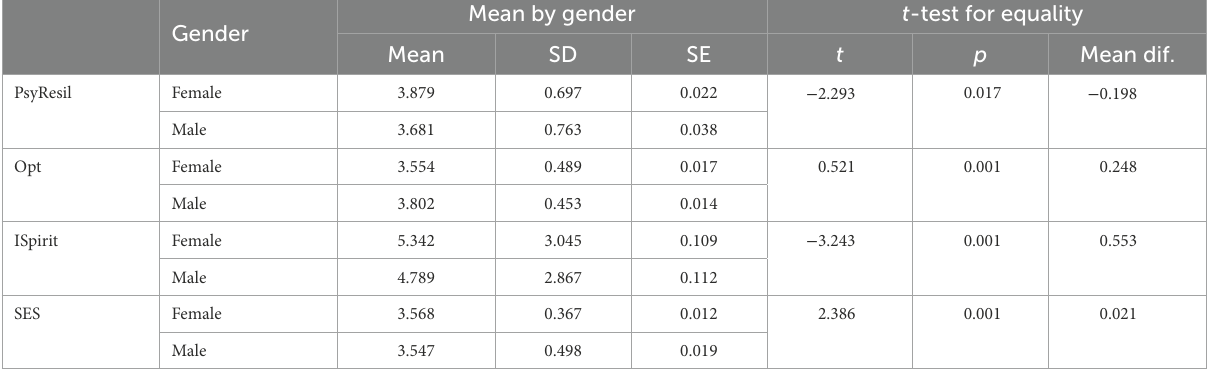
TABLE 5 Mean difference by